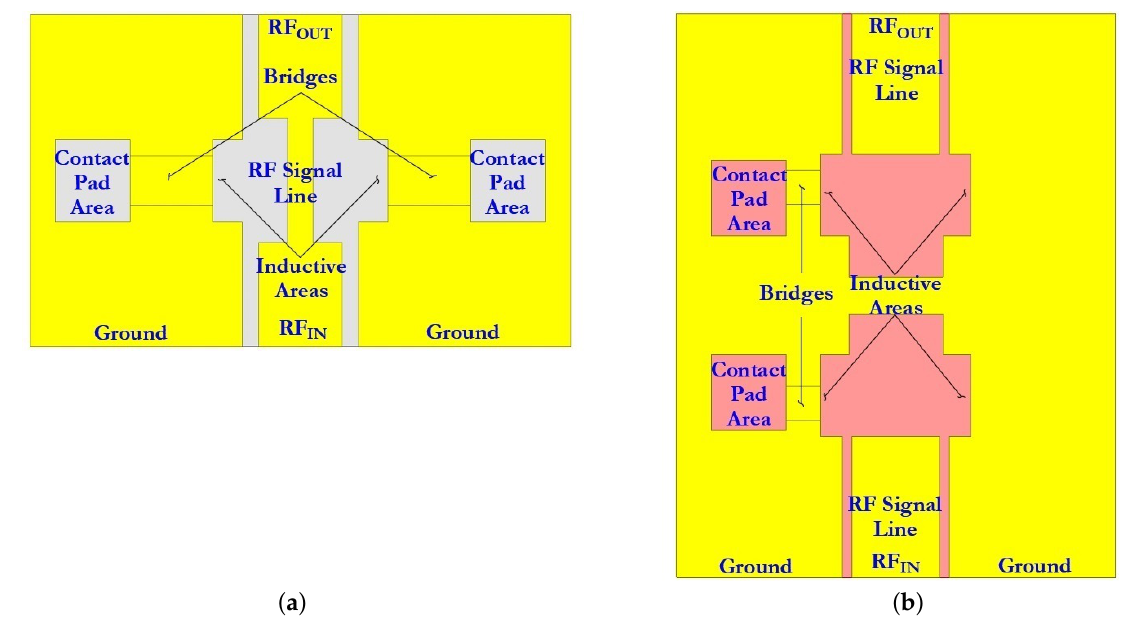
Figure 6. The CPW designs: ( a ) CPW (A) is RF MEMS switch (A); ( b ) CPW (B) is RF MEMS switch (B).